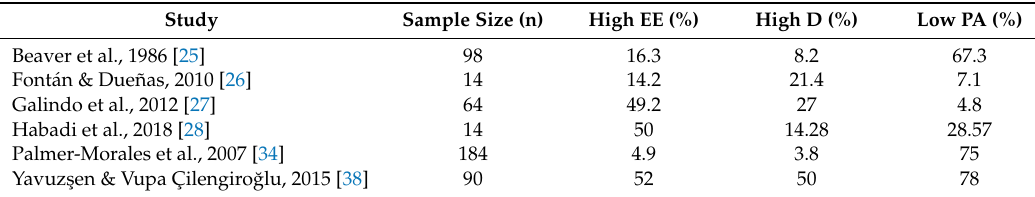
Table 2. Prevalence of high EE, high D, and low